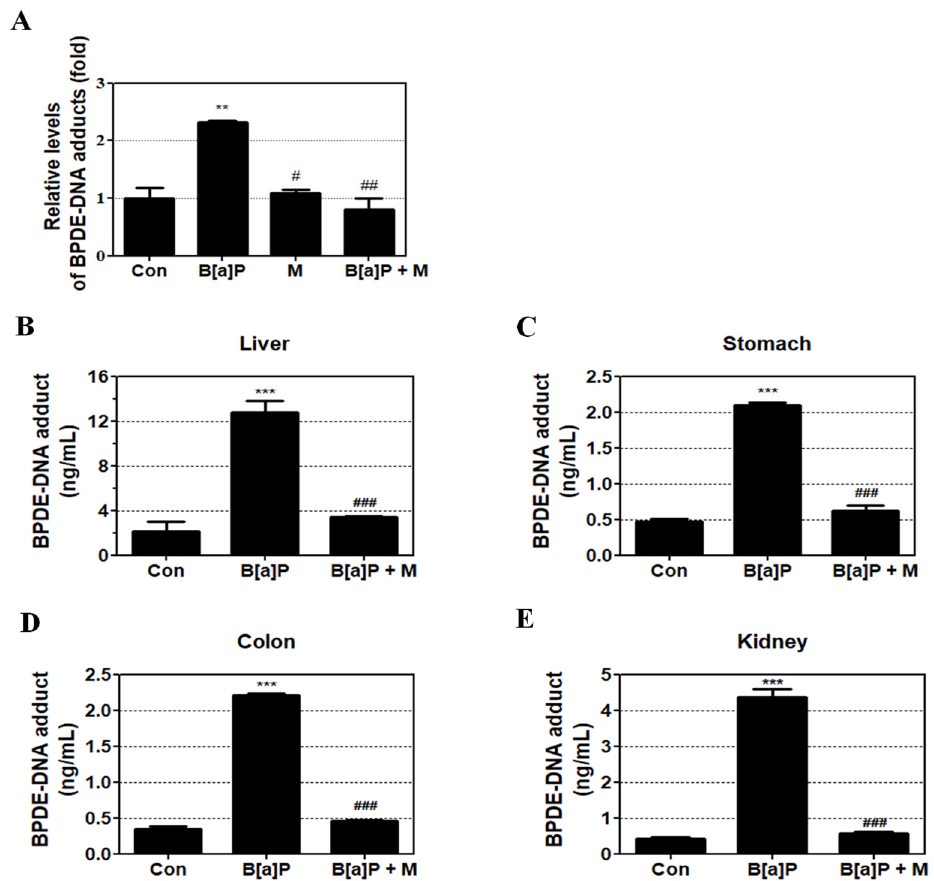
Figure 4. BPDE-DNA adduct concentration in B[a]P and B[a]P + myricetin treated groups. ( A ) Effect of myricetin on BPDE-DNA adduct formation in HepG2 cells following treatment with B[a]P (10 μ M) and co-treatment with myricetin (10 μ M) for 48 h. ( B–E ) In Sprague-Dawley rats, treatment with B[a]P (2 mg/kg) and co-treatment with myricetin (15 mg/kg) for 55 days. All treatment groups are significantly different when compared with controls (** p < 0.01, *** p < 0.001) and B[a]P (# p < 0.05, ## p < 0.01, ### p < 0.001). Tukey’s multiple comparison test. M: myricetin.